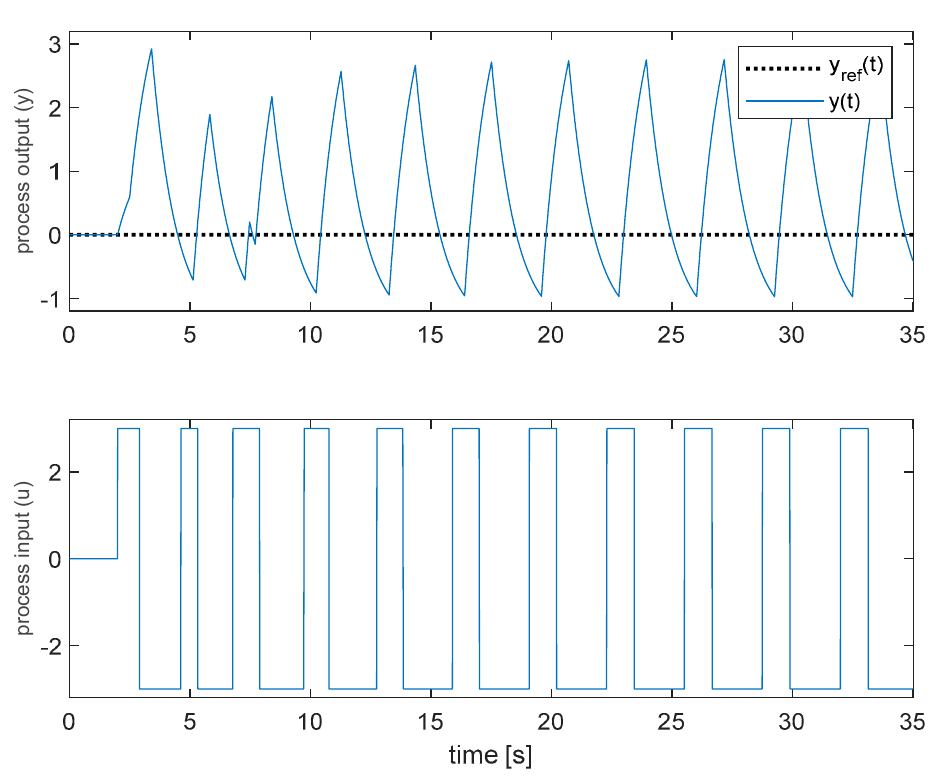
Figure 8. Response of the relay feedback method [1] combined with the time delay [7] for the first-order plus time-delay process with θ = 0.5 and PA set = − 3 π/4 .